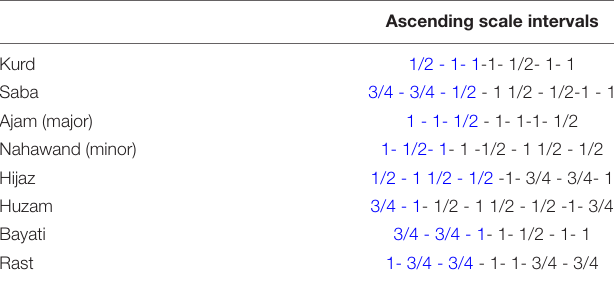
TABLE 1 | Interval signatures of the eight Maqam s